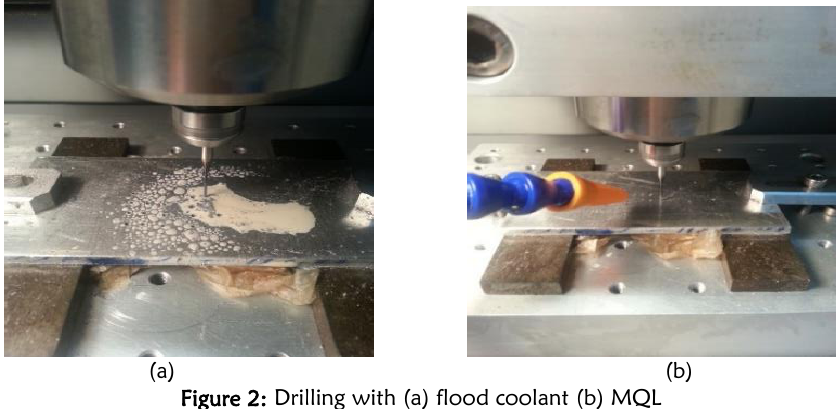
Figure 2: Drilling with (a) flood coolant (b)